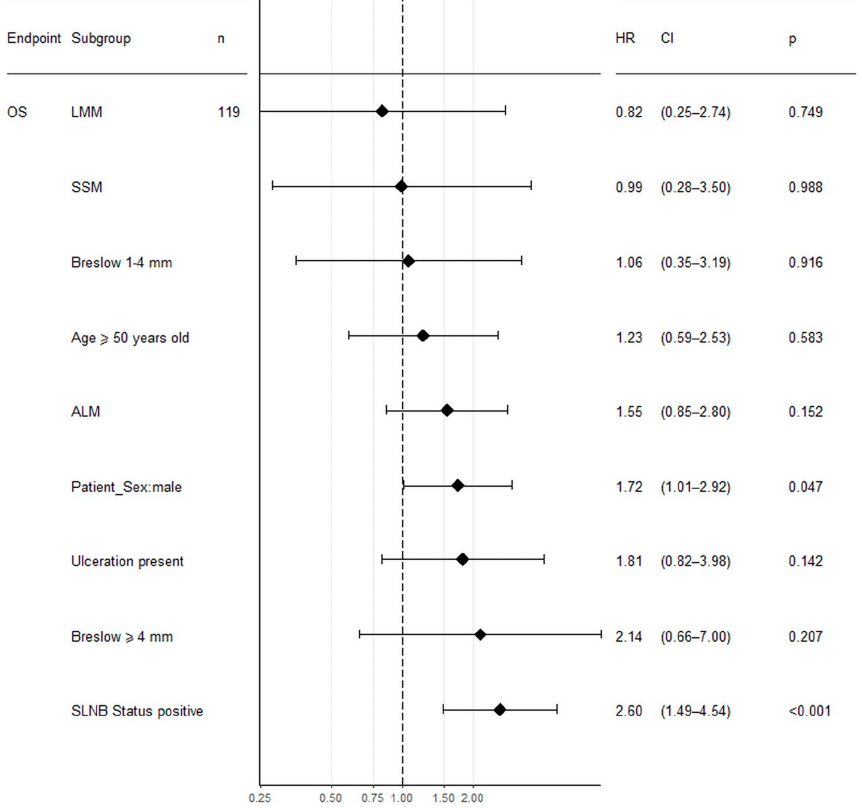
Figure 7. Kaplan–Meier estimation of the OS of non-HFM vs. HFM patients. Legend: HFM—hand and foot melanoma, OS—overall survival. 4. Discussion This study represents a large single-institution study of HFM in Caucasians with very long follow- up time. In our study, the mean age of HFM patients was 58.5 years, in line with the literature reporting a mean age for HFM and ALM varying from 55.3 to 69 years [5,9,21,26–30]. At the time of diagnosis,